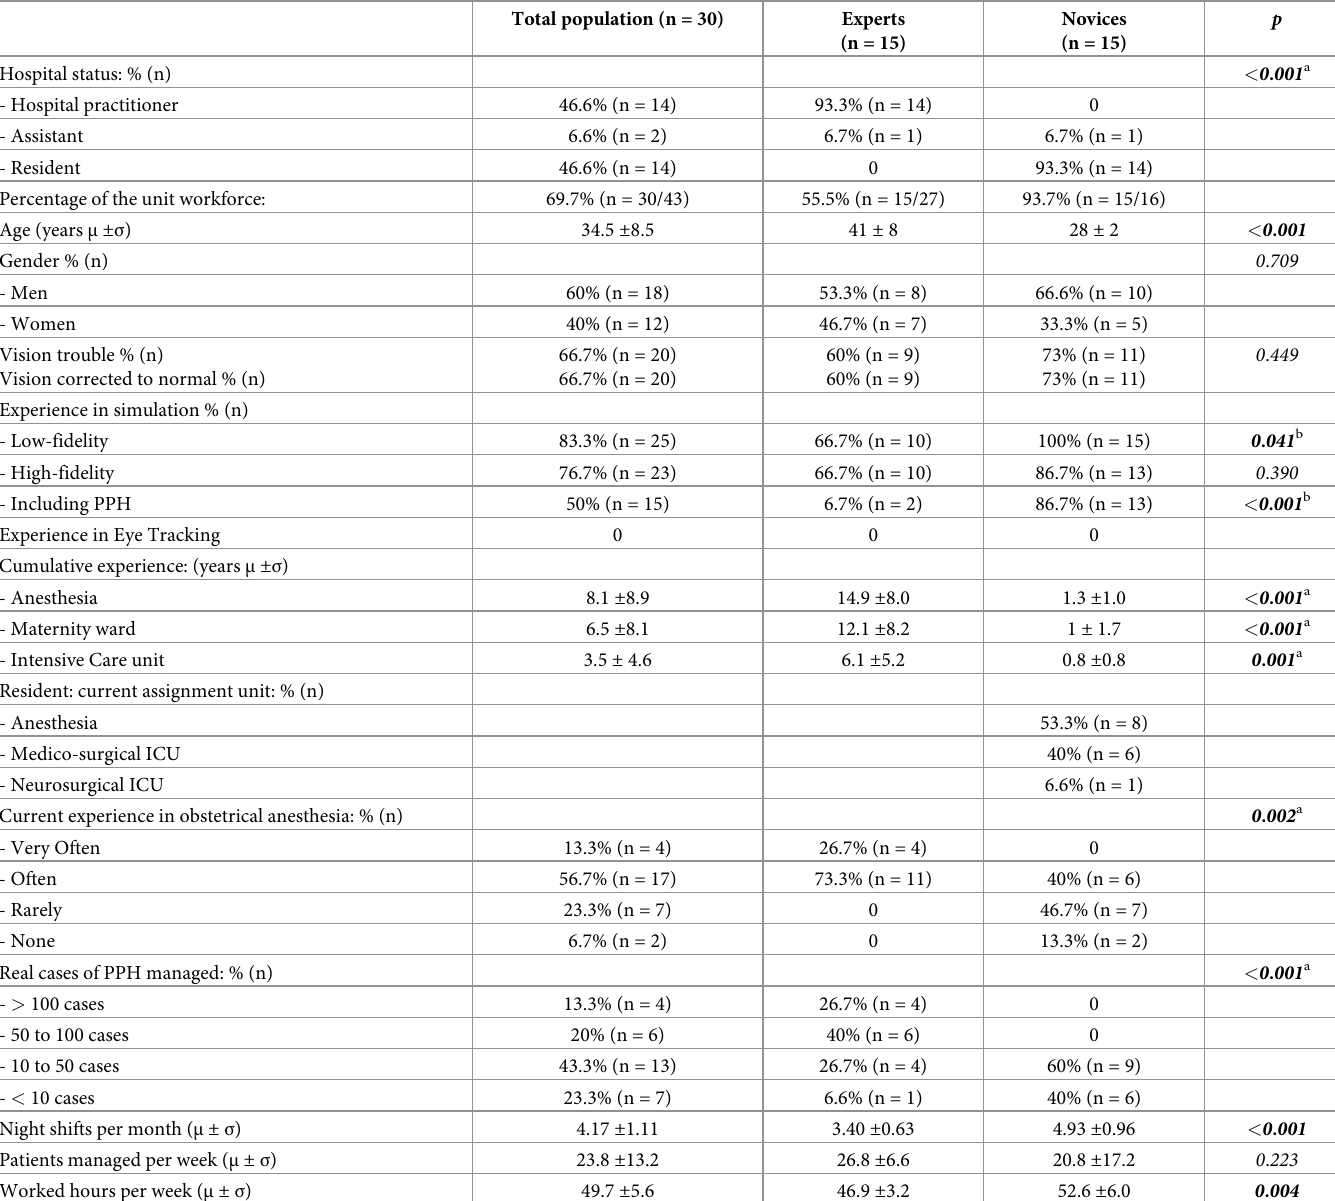
Table 1. Characteristics of the